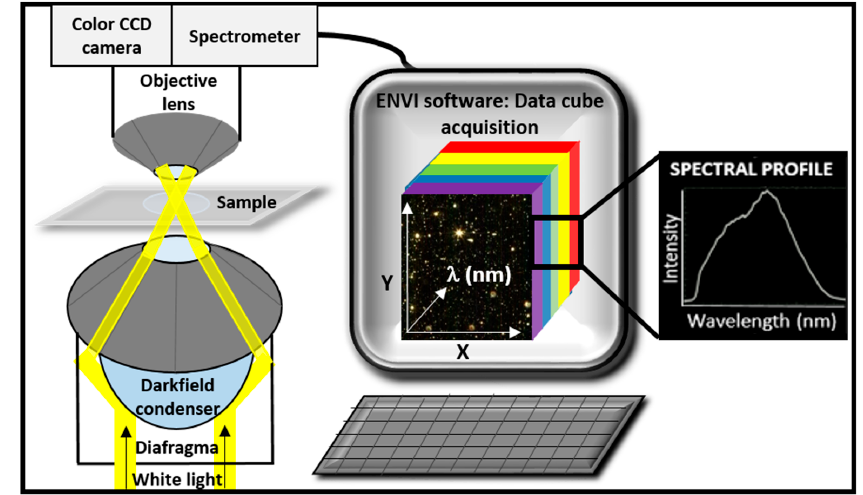
Figure 1. Generalized diagram of the Hyperspectral-Enhanced Dark Field Microscopy (HEDFM) system. Schematic illustration of the experimental setup based on dark field optics coupled with the spectrograph ( left ), and on the acquisition of the hyperspectral data cube for the analysis ( right ). Each pixel in the field of view provides complete spectral information in the optical window ranging from 400 to 1000 nm [8]. This system was acquired from CytoViva, Inc. (Auburn, AL,